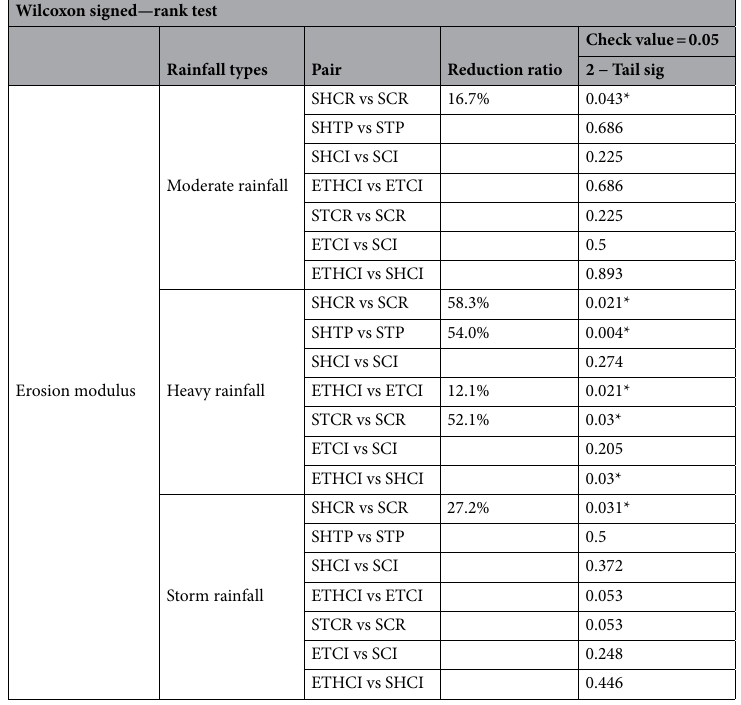
Table 4. The results of the significant differences between erosion modulus of different plots under different rainfall patterns obtained by the Wilcoxon signed rank test (p < 0.05, n = 5, 21, 18). *Represent p < 0.05.